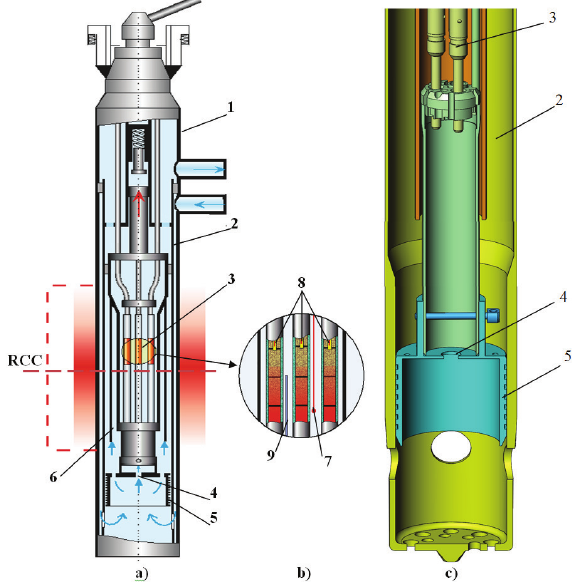
Figure 1. Experimental device: a) overall view; b) cross sec- tion in the reactor core center (RCC); c) coolant flow separa- tion node; 1. channel shroud; 2. coolant flow separator; 3. fuel elements; 4. hole; 5. labyrinth seal; 6. cavity with a stagnant aqueous medium; 7. thermocouple (TC) in the coolant; 8. TC (T , T , T respectively) in the fuel kernel center; 9. direct charge 1 2 3 detector